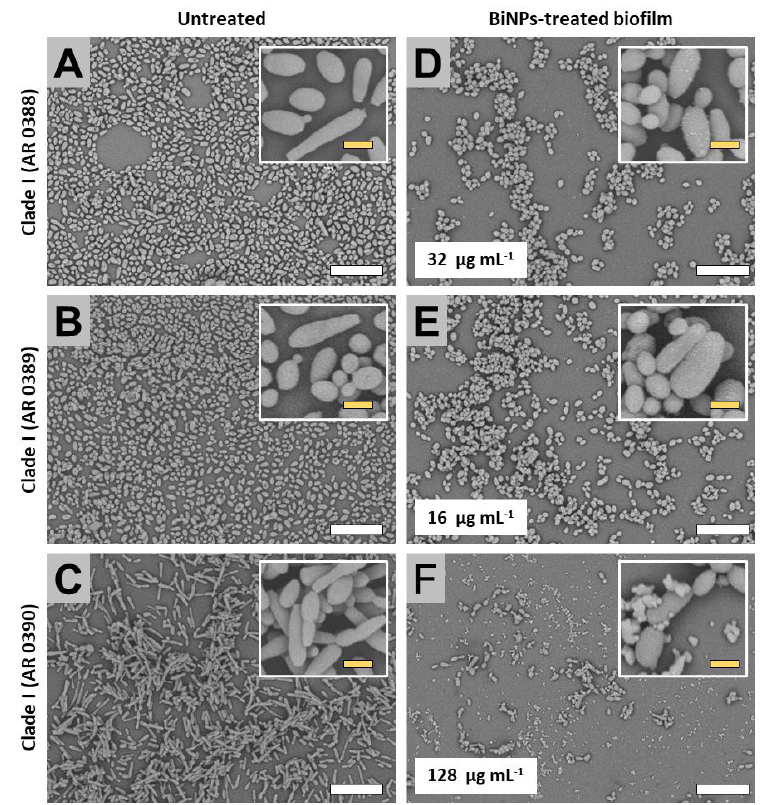
Figure 2. SEM observations on the BiNP antibiofilm activity on the C. auris strains from the Clade I (subgroup 1). BiNPs display a reduced biofilm formation—when compared to the untreated control—on the C. auris strains no. 0388 ( A,D ), no. 0389 ( B,E ), and no. 0390 ( C,F ). The cell morphology is also affected by the BiNPs (A – F). Scale bar: yellow 2 µm, white = 20 µm.